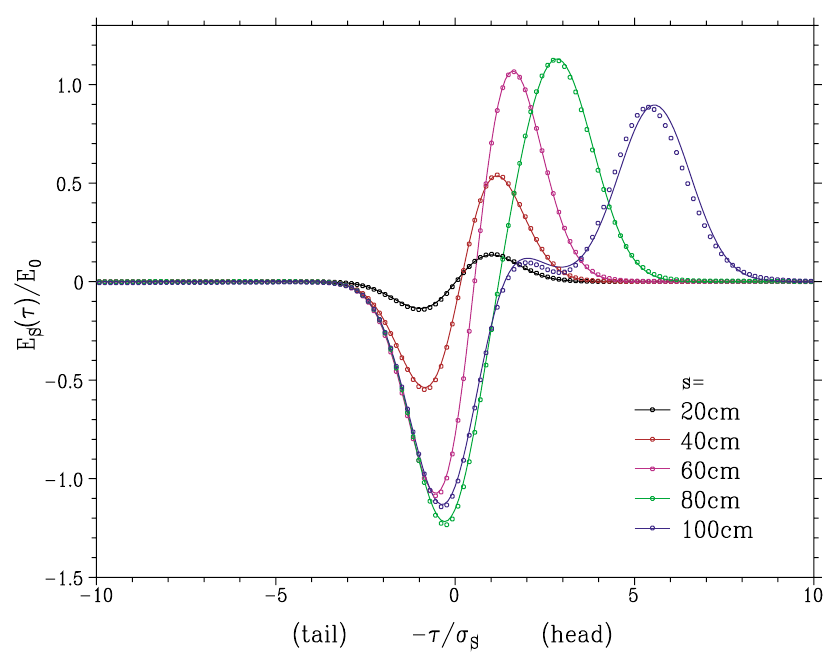
FIG. 3. (Color) The longitudinal electric field E at x (cid:1) y (cid:1) 0 in transient state without shielding. The analytic solution is plotted s with solid lines and the dots are the simulation results. The different colors indicate the tracking length from the entrance of the magnet: s (cid:1) 20 cm (black), 40 cm (red), 60 cm (magenta), 80 cm (green), and 100 cm (blue), respectively. The size of the chamber cross section is w (cid:10) h (cid:1) 34 cm (cid:10) 28 cm